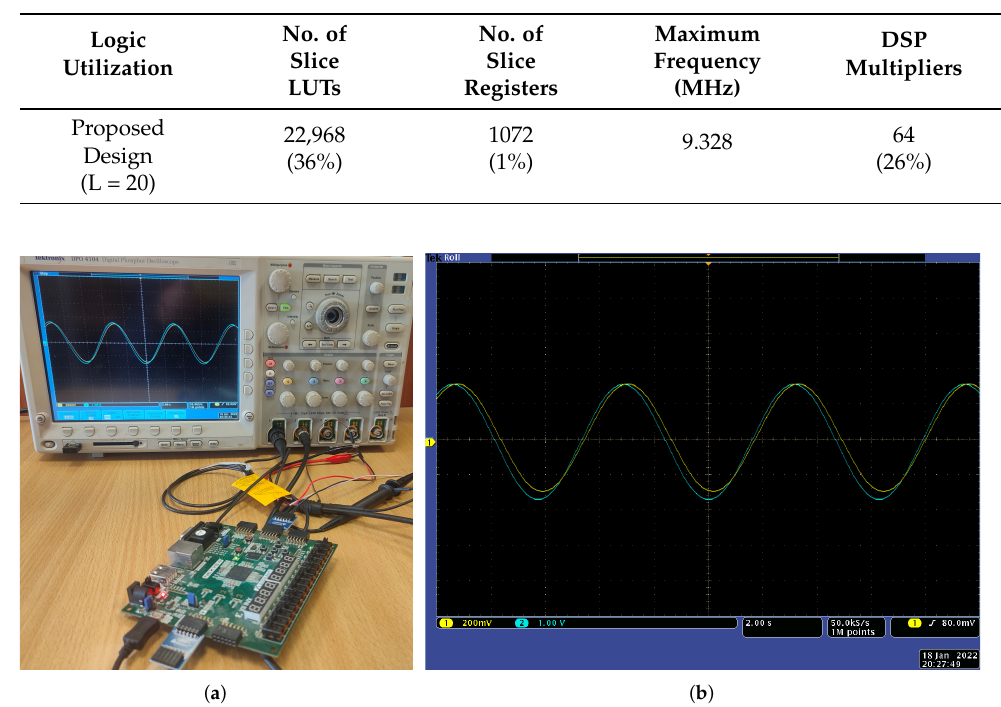
Table 6. FPGA hardware resources summary on XC7A100T.